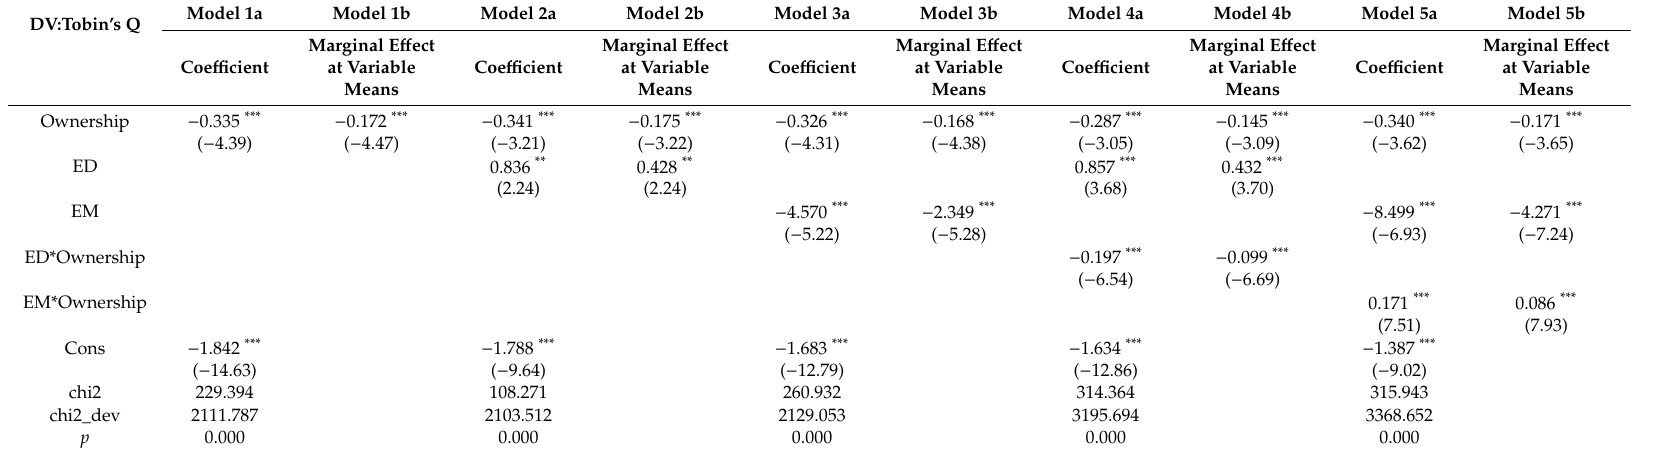
Table 3. GEE estimations of the antecedents of technological